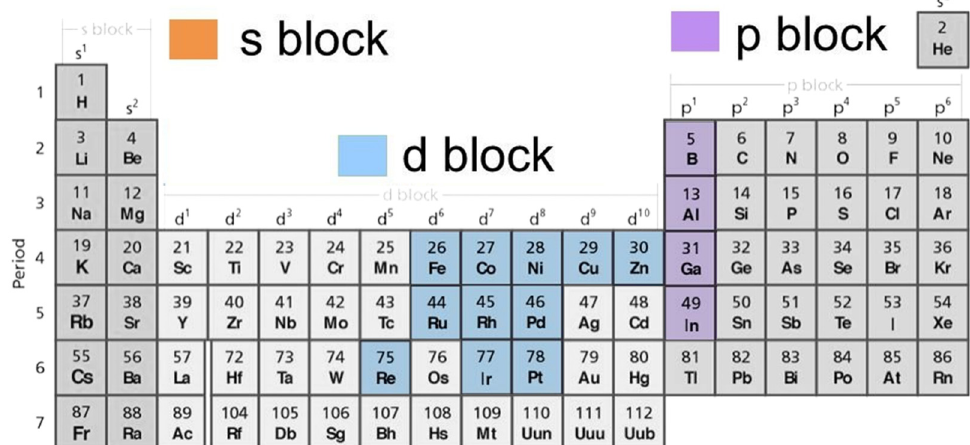
Figure 2. Periodic table visualizing the elements of which the dipyrrinato complexes are discussed in this work for their potential as PS’s for PDT (colored). Octahedral homoleptic tris(dipyrrinato) complexes discussed here, are formed mainly by Al(III) d 0 , Ga(III) d 10 , In(III) d 10 , Fe(III) d 5 , Co(III) d 6 and Rh(III) d 6 . Tetrahedral or square planar bis(dipyrrinato) complexes are formed mainly by Co(II) d 7 , Ni(II) d 8 , Cu(II) d 9 , Zn(II) d 10 and Pd(II) d 8 . Heteroleptic mono(dipyrrinato) complexes are formed